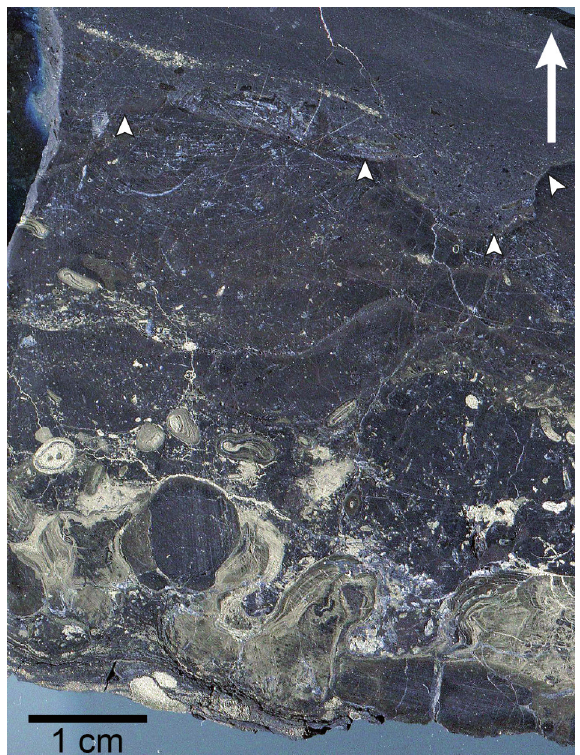
Fig. 3. Photo of the Fågelsång Phosphorite from just above the 20­m level in the Röstånga­2 drill core. This is the first record of this lithologically characteristic bed in the Röstånga area. The arrow is placed just above the top surface of the bed. Note the conglomeratic nature of especially the lower part of this bed and the apparent disconformity surface in its upper part (marked by